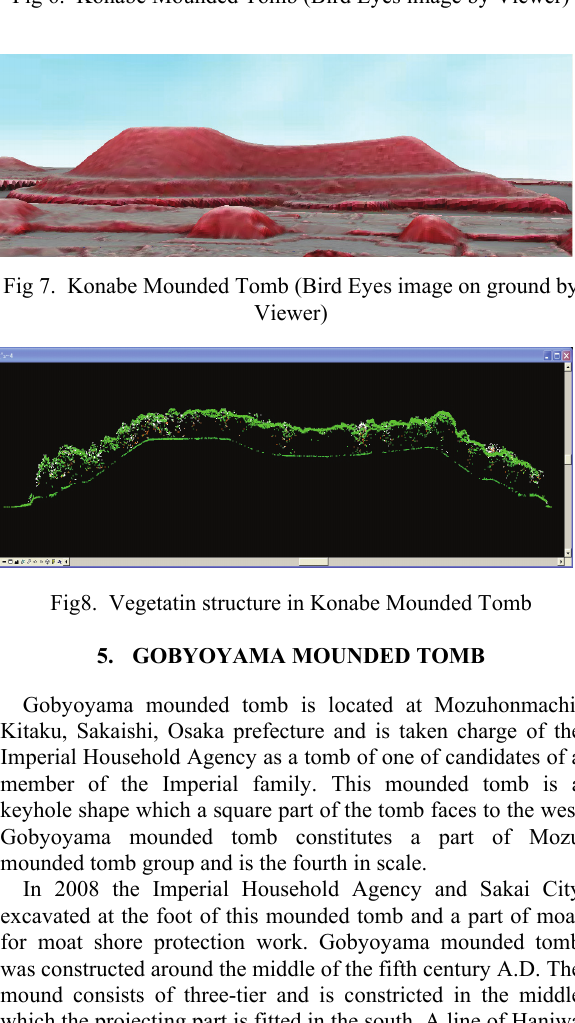
Fig 6. Konabe Mounded Tomb (Bird Eyes image by Viewer)